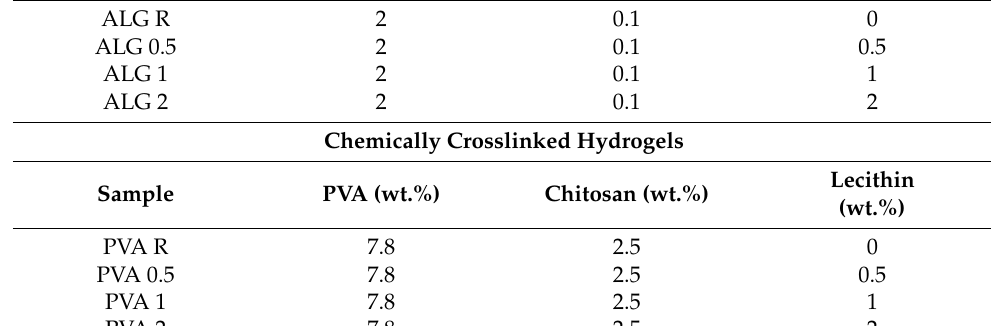
Table 10. Concentrations of each individual component in the final hydrogel form (agarose, sodium alginate, calcium chloride, PVA, chitosan, and lecithin). Physically Crosslinked Hydrogels Sample Agarose (wt.%) Lecithin (wt.%) AG R 1 0 AG 0.5 1 0.5 AG 1 1 1 AG 2 1 2 Ionically Crosslinked Hydrogels Sodium Calcium Chloride Lecithin Sample Alginate (wt.%) (mol · dm 3 ) (wt.%) ALG R 0.1